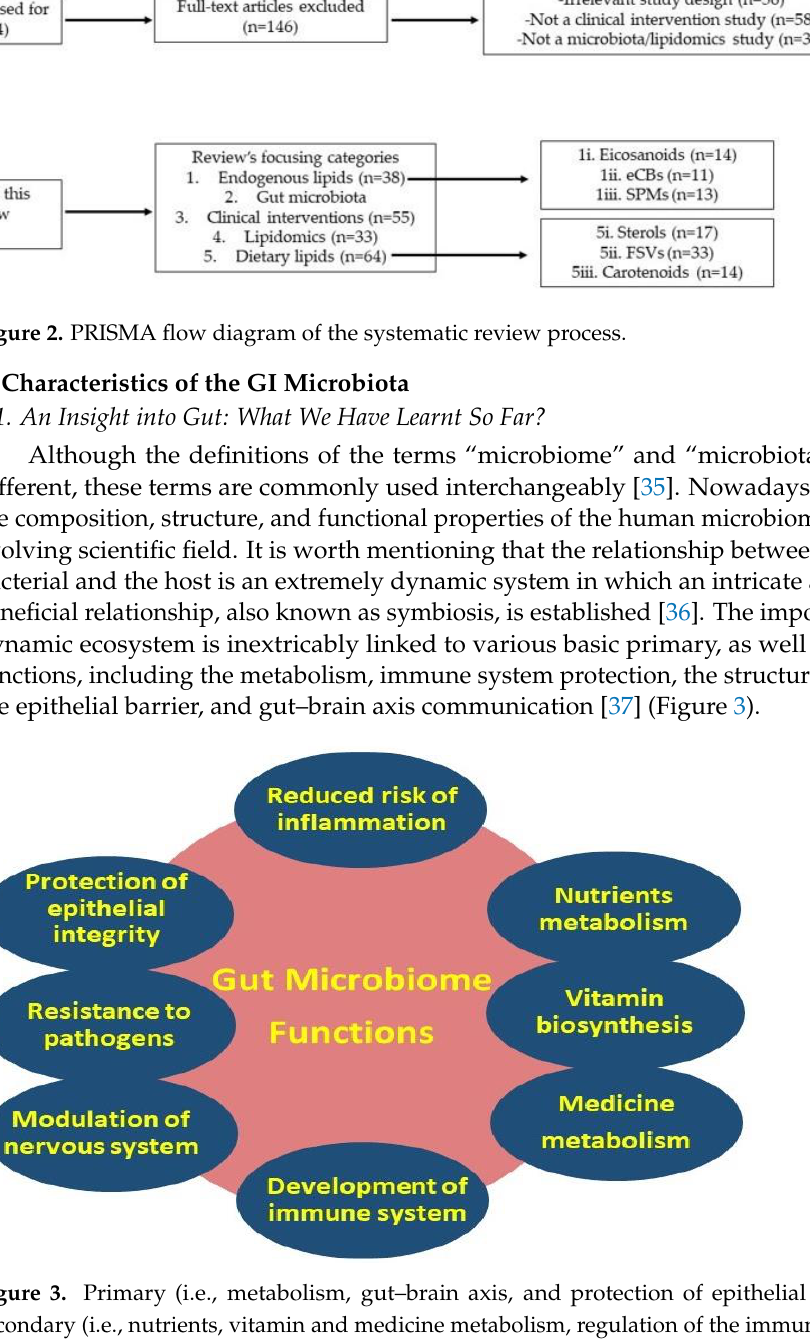
Figure 3. Primary (i.e., metabolism, gut – brain axis, and protection of epithelial integrity) and sec- ondary (i.e., nutrients, vitamin and medicine metabolism, regulation of the immune and nervous systems, and resistance to pathogens) gut microbiome functions. There is growing evidence that several gut disorders involve not only the GI system but distant organs as well [38]. Through a complex communication that includes the cen- tral nervous system as well as the autonomic and the intestinal nervous system, two-way